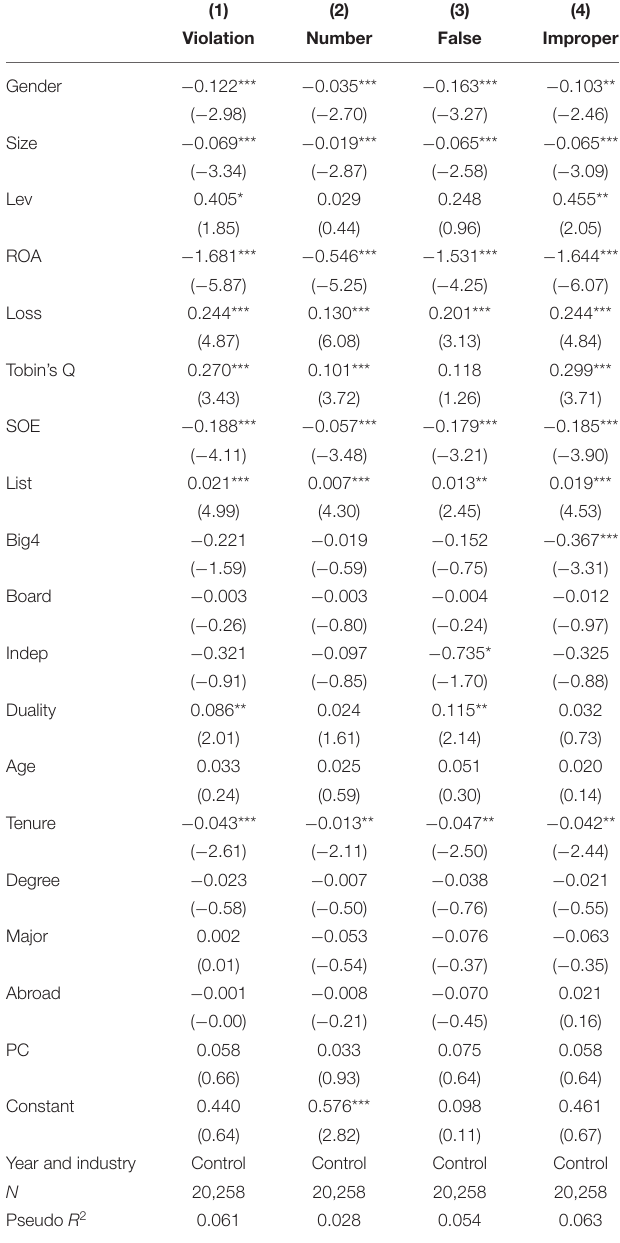
TABLE 2 | Female CFOs and information disclosure